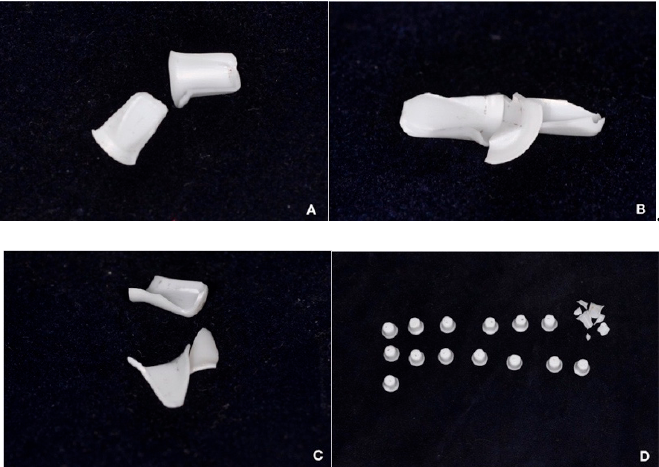
Figure 3. Specimens on four implant abutment designs after testing. A, the SA100 specimen was broken around the top and axial wall corner with apparently broken line. B, the SA75 specimen was broken into three segments. C, the SA50 specimen with fractured segments. D, one zirconia specimen on the SA25 abutment design was broken into multiple segments, and the remaining specimens’s morphology remained intact.